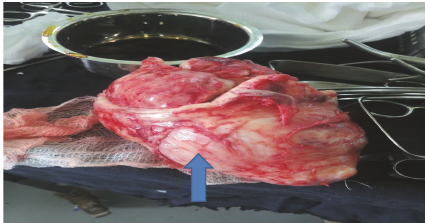
Figure 3: Gross appearance of the excised mass (blue arrow).